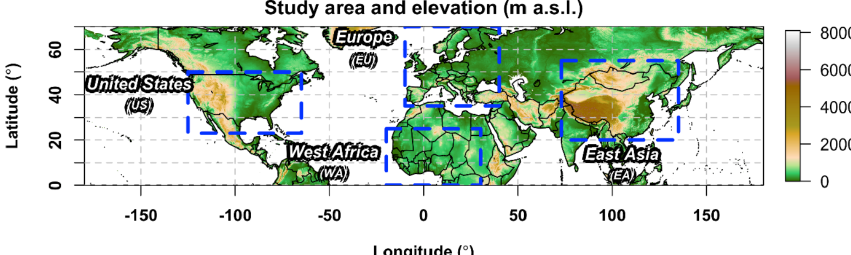
Figure 1. Study area, including East Asia, Europe, the United States and West Africa, and elevation (m a.s.l., above sea level). The dashed blue boxes represent the boundaries of each study region.